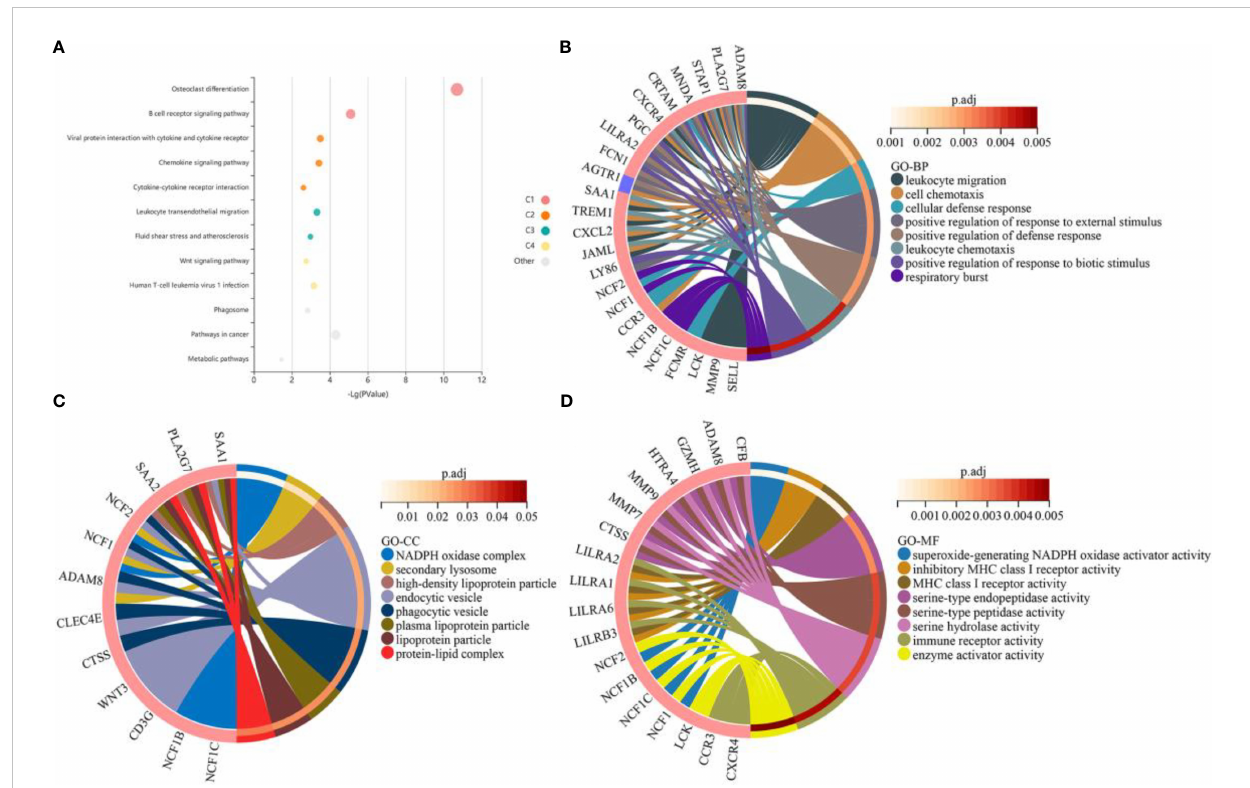
FIGURE 2 Functional enrichment analysis of the common differentially expressed genes (DEGs) between obesity and periodontitis. (A) KEGG pathway analysis of the DEGs. Where each bubble represents an enriched function, the size of the bubble represents 6 levels of enriched p -values, and the color of the bubble indicates the clustering of different pathways corresponding to different clusters (C1, C2, C3, etc.). (B – D) GO enrichment results of the DEGs for the categories of biological processes, cellular composition and molecular function. The red and blue colors of the gene represent up- regulation and down-regulation respectively. An adjusted p -value < 0.05 was considered statistically signi fi cant. DEGs, differentially expressed genes. KEGG, Kyoto Encyclopedia of Genes and Genomes. GO, Gene